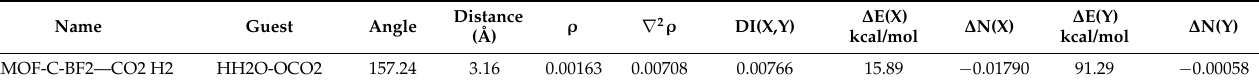
Table 7. Topological parameters of the BCP of bond in adsorption configurations of guest molecules (CO 2 and H 2 ) on IRMOF-C-BF 2 —-CO 2 H 2 . Guest intermolecular interactions.